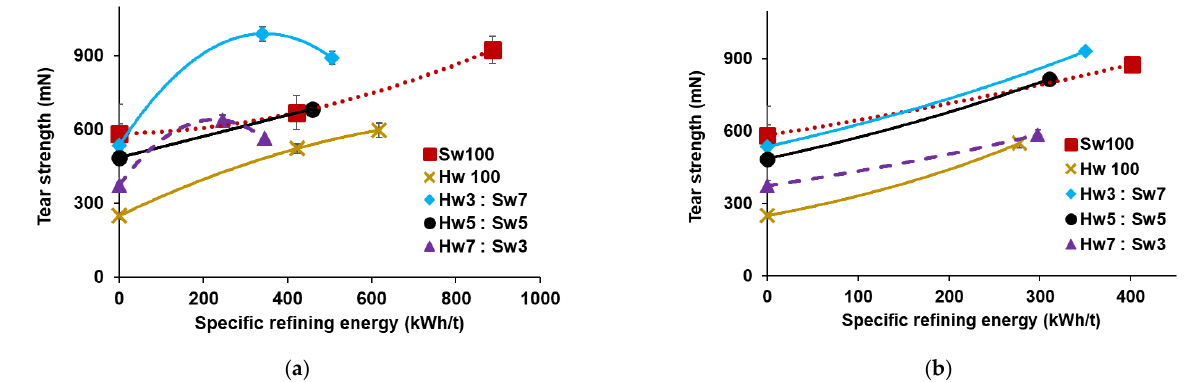
Figure 12. Effect of CEL on tear strength of paper made of mixed pulps: ( a ) PA55; ( b ) PB97. Unlike PA55, when refining with PB97, tear resistance increased irrespective of the pulp mixing ratios of Sw-BKP and Hw-BKP, and the sheets prepared from the pulps with more Sw-BKP showed better tear resistance than those prepared from Hw-BKP alone at each refining step. It was interesting to note that the sheet with a mixing ratio of Sw-BKP and Hw-BKP of 7:3 also displayed the best tear resistance. In particular, much less refining energy in the final tear strength was much less consumed in the fine bar plate PB97 than in PA55. 3.3. Stock Throughput Figure 13 compares the stock throughput of the mixed pulps passing through the plate grooves of PA55 and PB97 during refining. It was found that it was much easier for pulp fibers to pass through the refiner plates with rectangular grooves between the bars than the plates with trapezoidal grooves [18]. However, as shown in Figure 13, different stock throughputs were obtained depending on the CEL values between the plates having the same rectangular grooves. Although PA55 with a smaller CEL has slightly wider grooves than PB97, when compared to the same refining energy, the stock throughput of PA55 was smaller or similar to that of PB97. As a result, it was confirmed that the plates with a vertical bar shape were not substantially different in terms of stock throughput despite different CEL values.